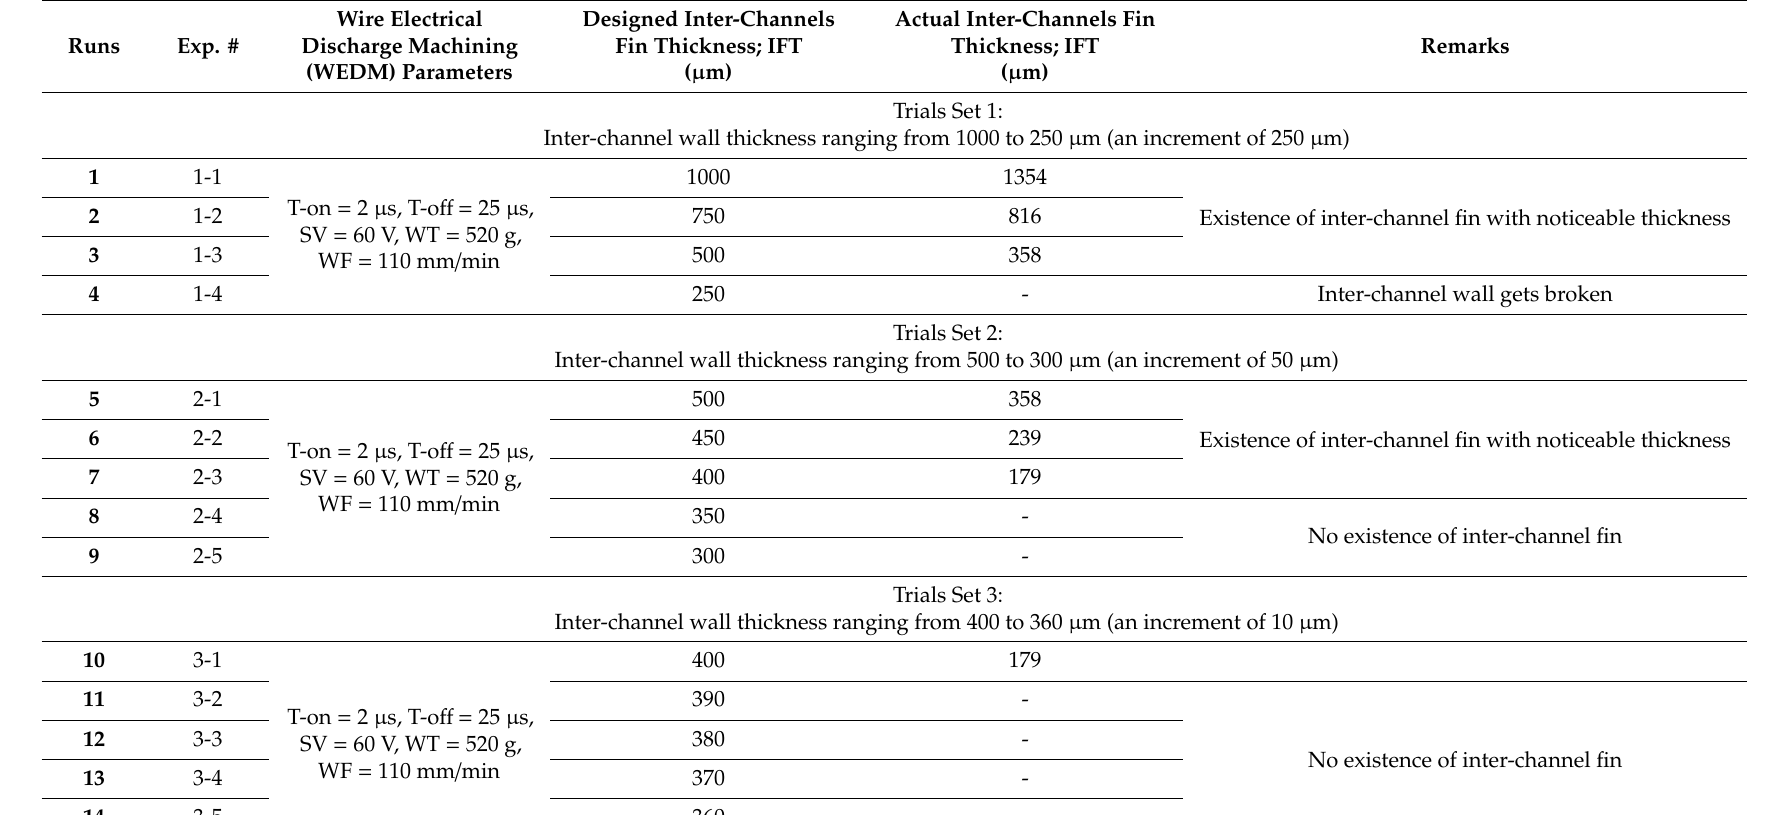
Table 3. Screening of micro-channel sizes (based on inter-channel fin thickness) and machining